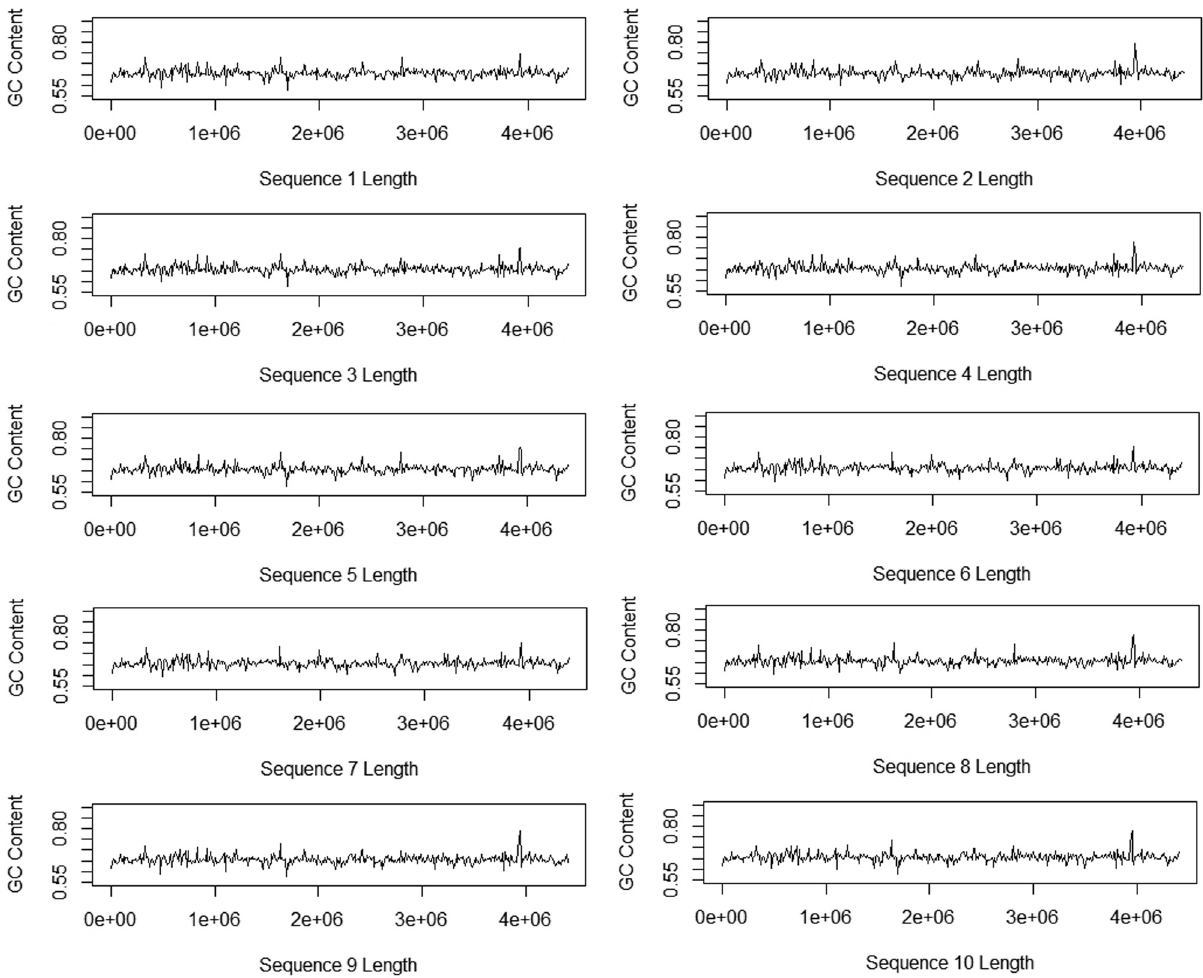
Figure 2 - GC-content sequence sign (10,000 bp window) of MTB